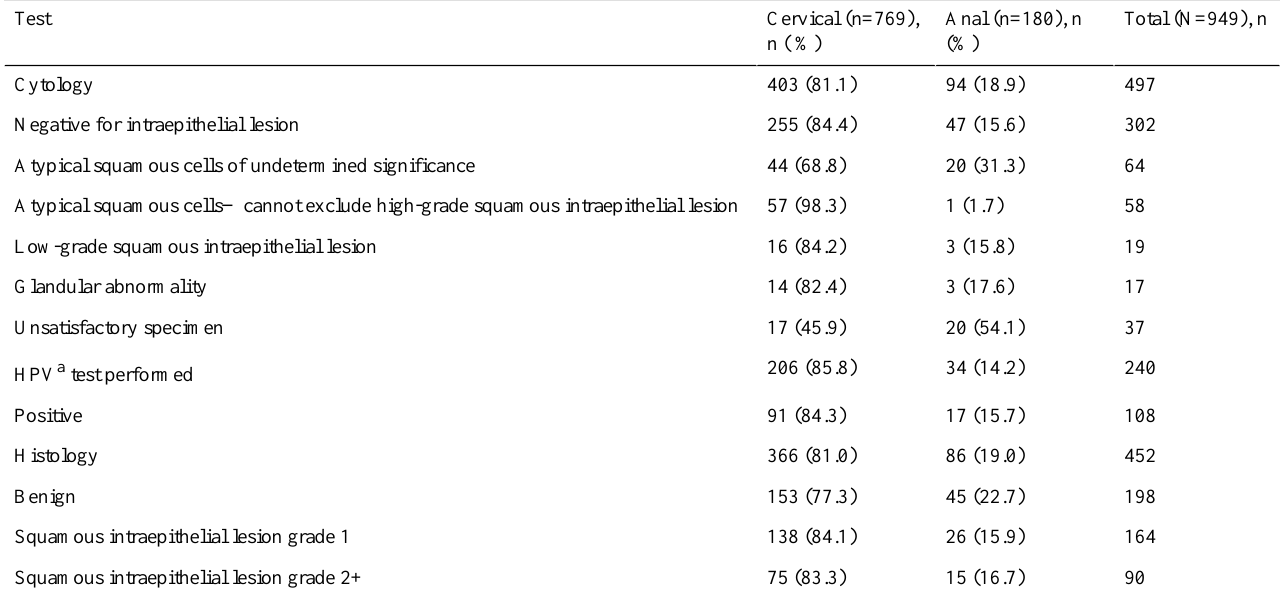
Table 1. Summary of results from the manual review of the validation